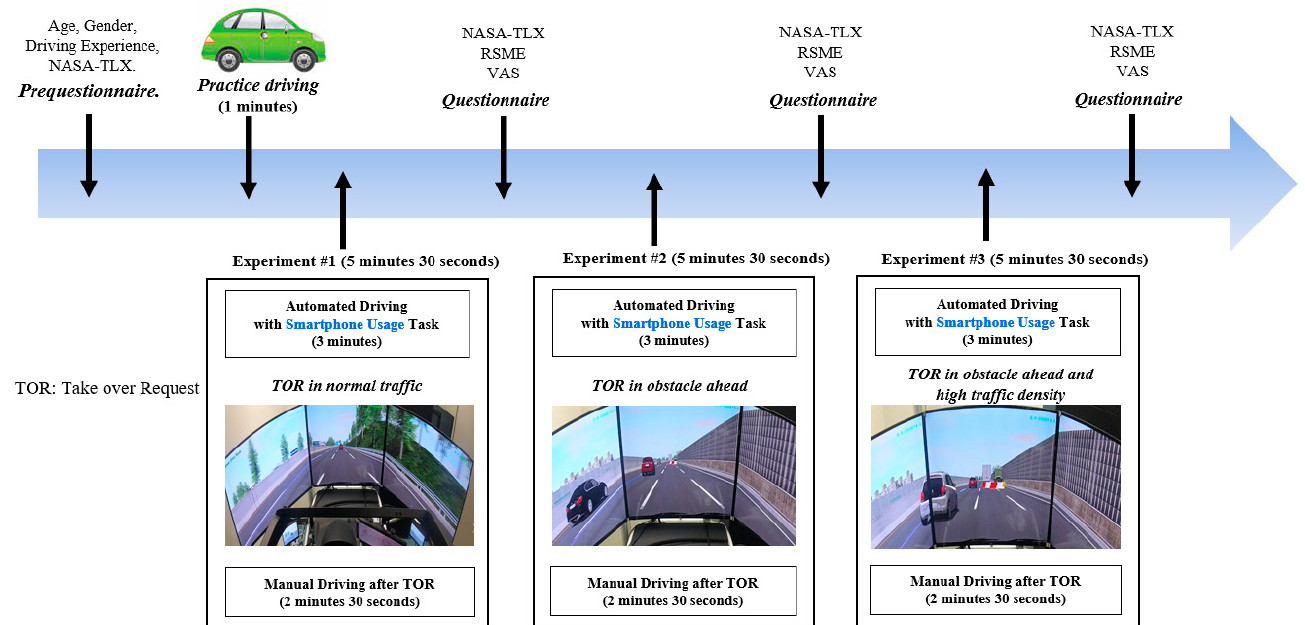
Figure 3. Experiment procedure.